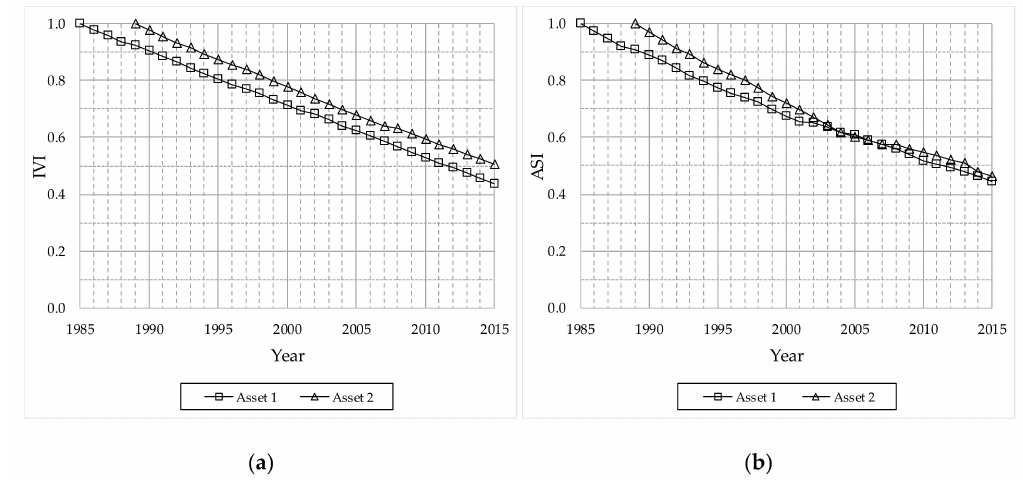
Figure 5. Asset condition assessment for Assets 1 and 2: ( a ) IVI index; ( b ) ASI